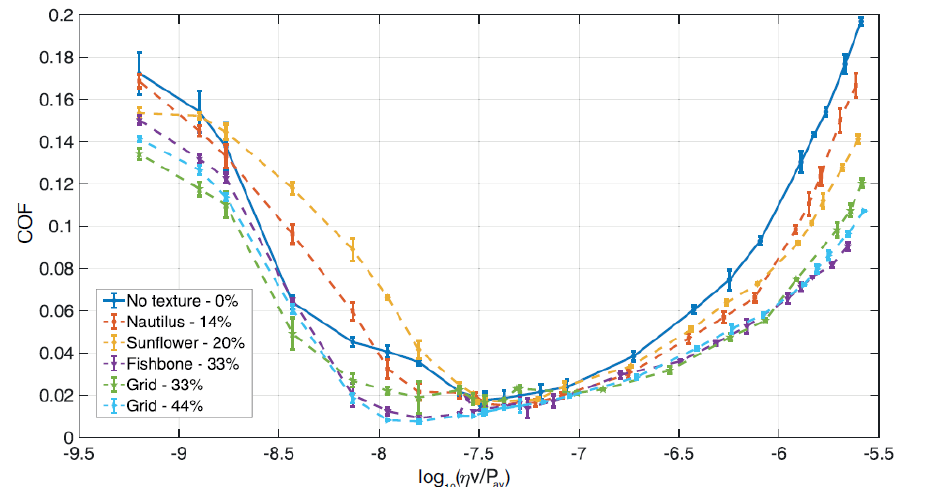
( η v / P av ) for the untextured 10